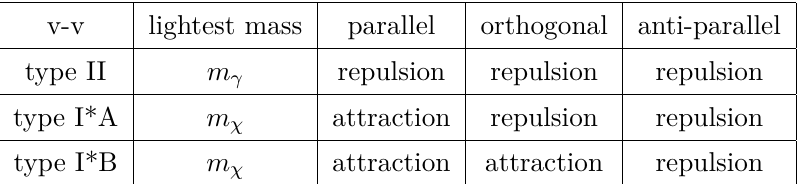
Table 2 . Static inter-vortex force between non-Abelian vortices.